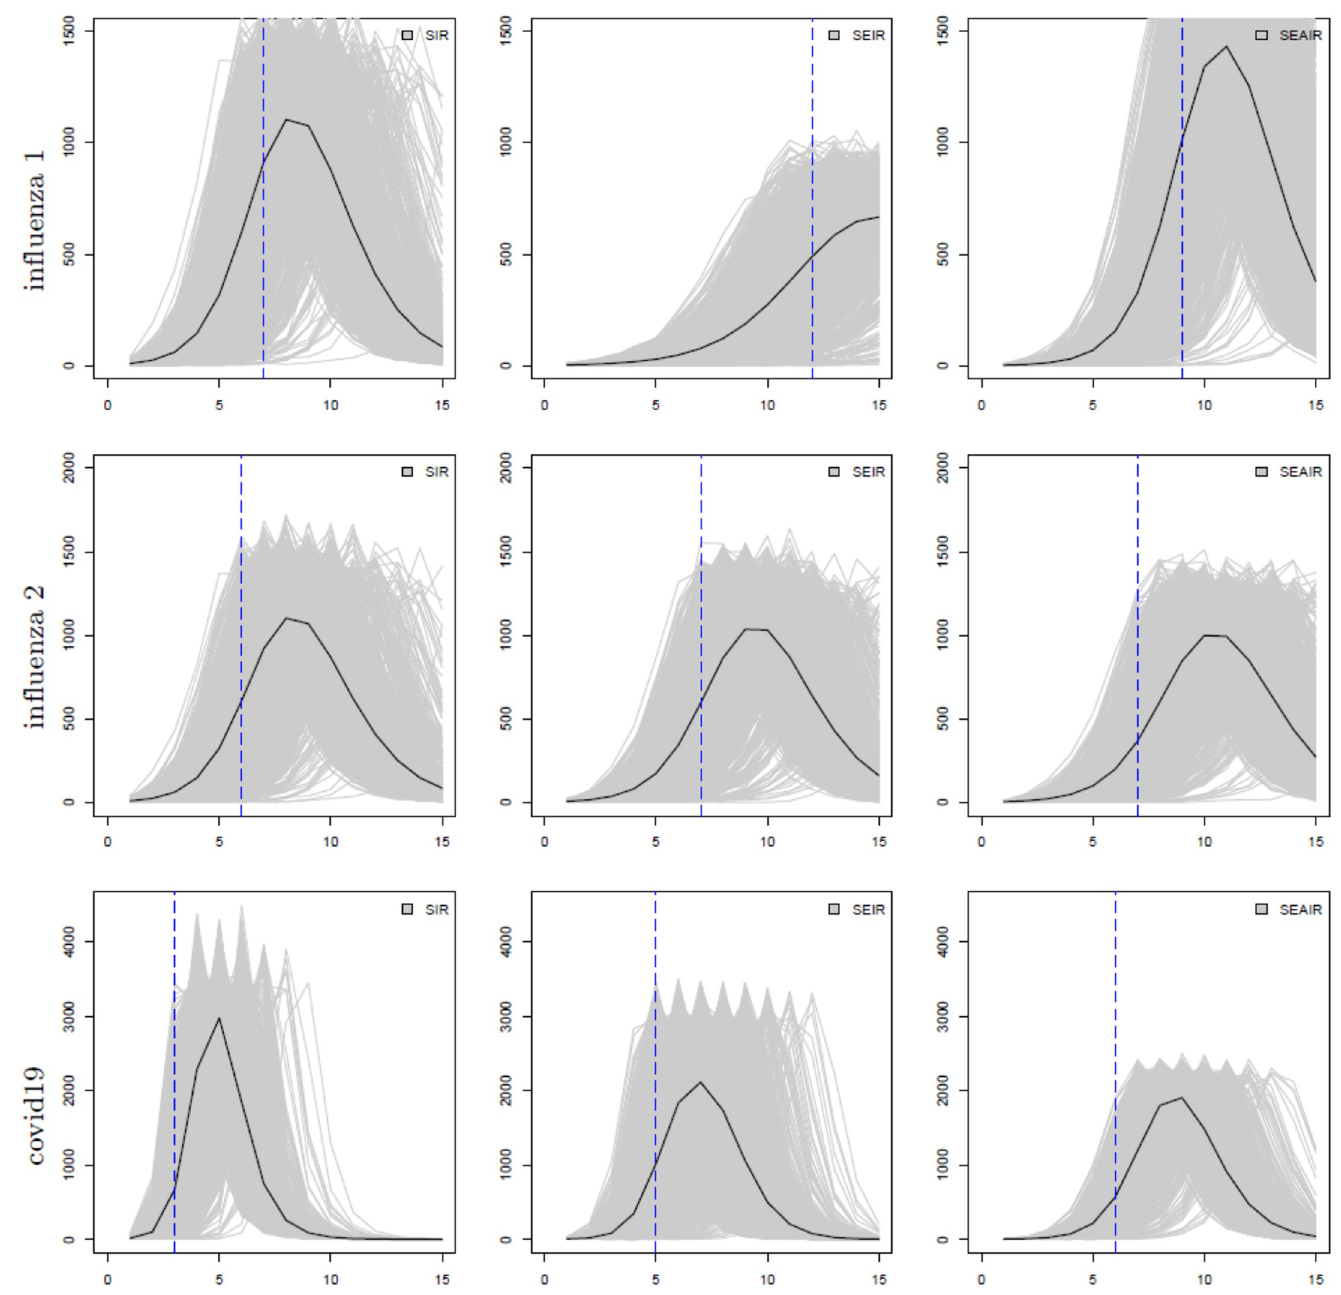
Fig 1. The number of infectious individuals ( y -axis) at time t in weeks ( x -axis); from left to right: SIR, SEIR, and SEAIR; from top to bottom the examples are influenza 1, influenza 2, then covid19. Individual simulated outbreaks from 1000 simulations are shown as grey lines, and their average is denoted as a black line. The blue vertical dashed lines show the inflection points for each